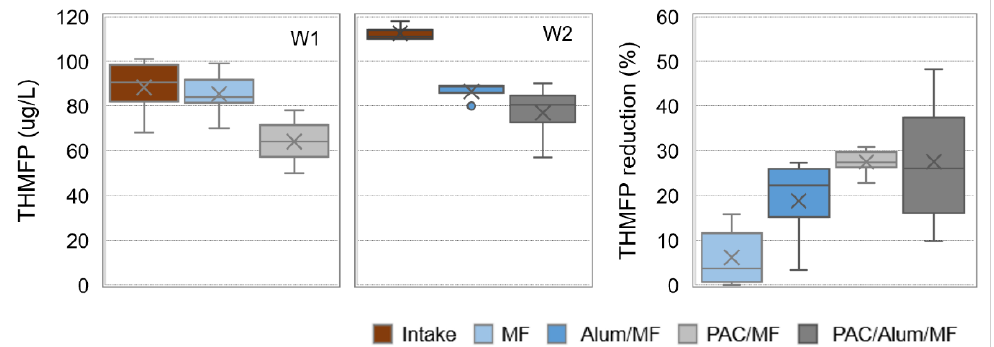
Figure 8. Trihalomethane formation potential in pilot intake (W1 and W2) and permeate water after MF and PAC/MF (for W1, 7–13 mg/L PAC) or Alum/MF and PAC/Alum/MF (for W2, 2–3 mg/L Al 2 O 3 and 4–13 mg/L PAC) and respective removals (box plots with maximum, P75, average, median, P25 and minimum values; little circles are outliers).